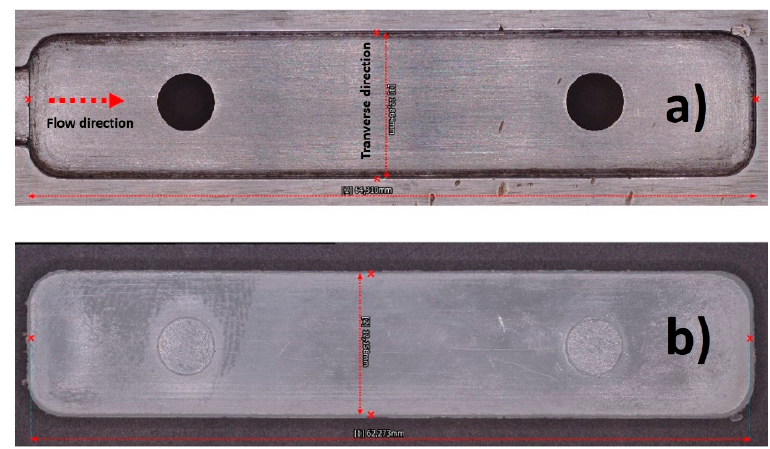
Figure 15. ( a ) mold cavity and ( b ) injected flexural specimen.